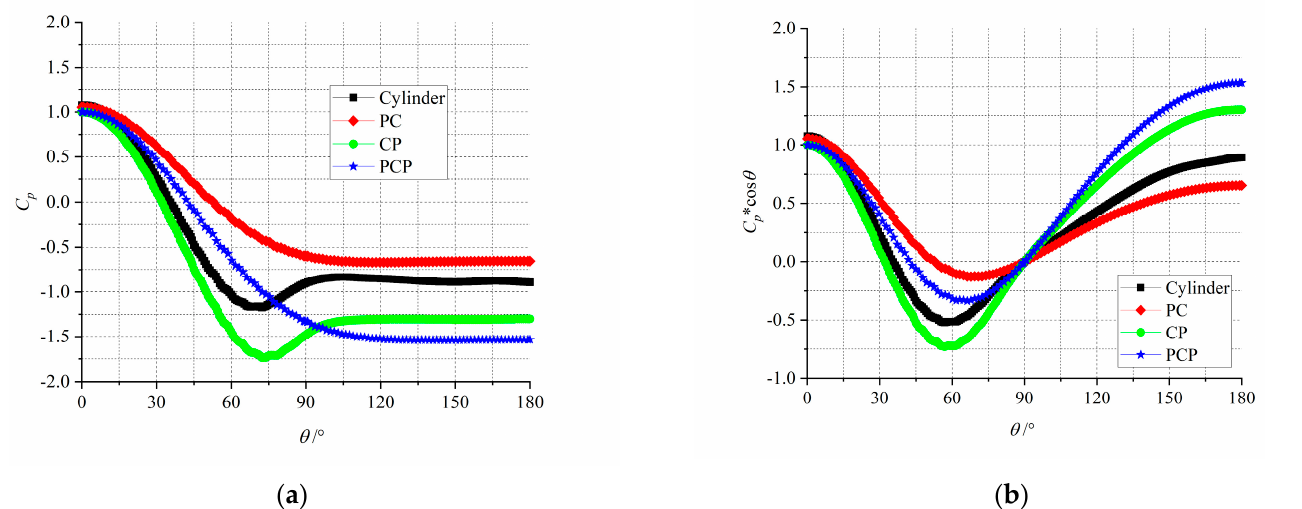
Figure 7. Time-averaged static pressure coefficient distribution. ( a ) pressure coefficient variation; ( b ) pressure drag variation.